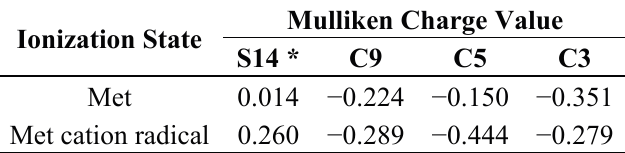
Table 2. The Mulliken charge distribution in Met and corresponding radical and cation